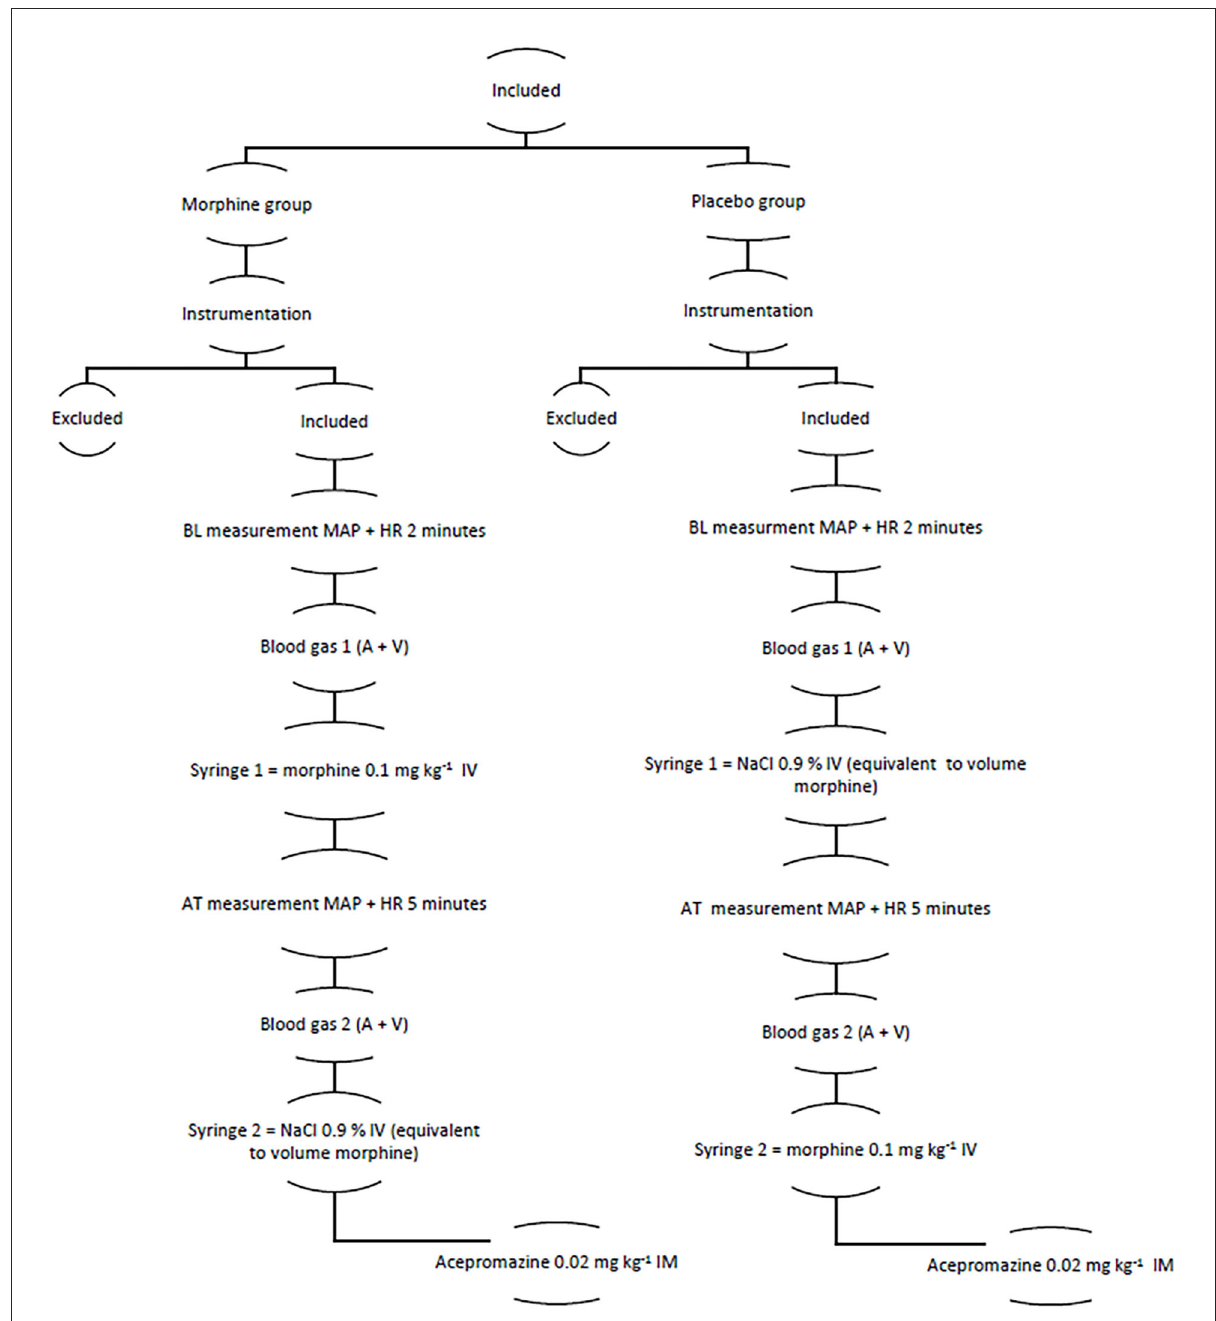
FIGURE1 The figure showing the structure of the clinical trial A, arterial; AT, after treatment; BL, baseline; HR, heart rate; MAP, mean arterial pressure; V,